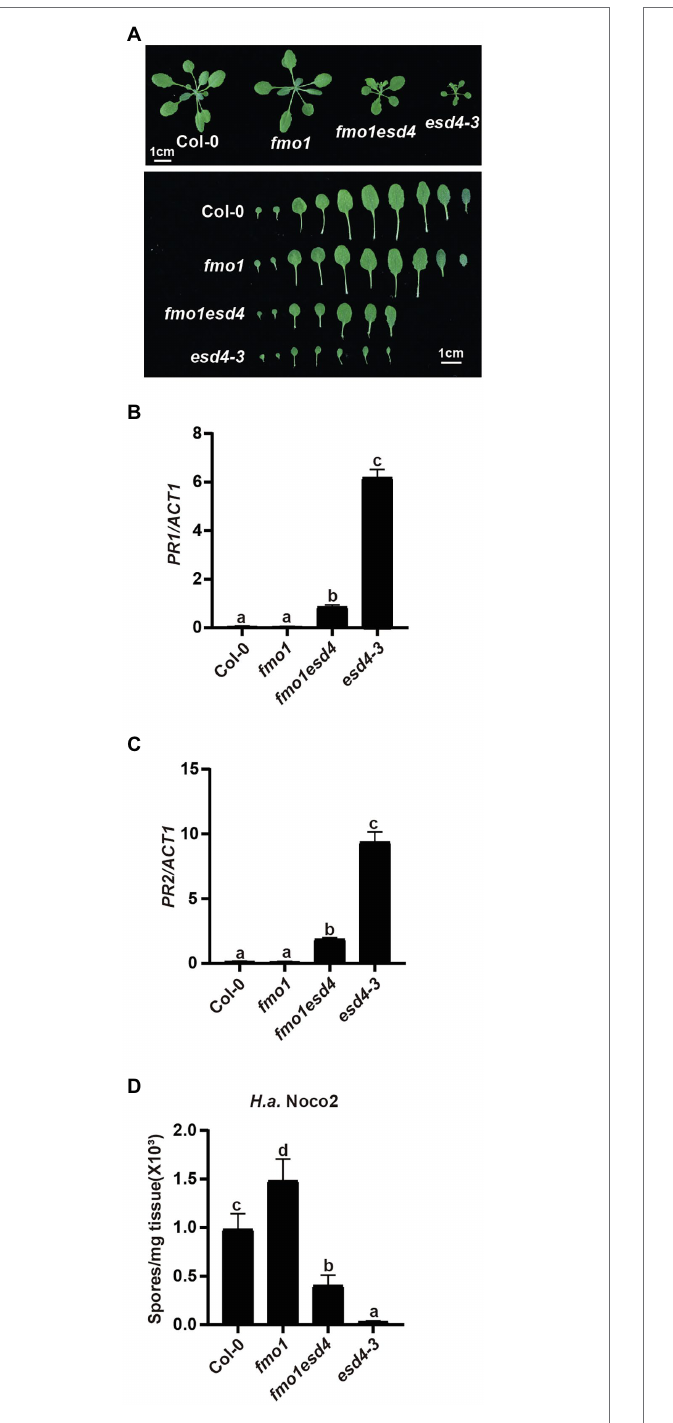
FIGURE 3 | The constitutively activated immunity in esd4 is partially suppressed by fmo1 . (A) Morphologies of 3-week-old soil-grown plants of the indicated genotypes under long-day conditions. (B,C) Expression of PR1 (B) and PR2 (C) in indicated genotypes. ACTIN1 serves as internal control. (D) Growth of H.a. Noco2 on the indicated genotypes. The values indicate averages of replicates ± SD ( n = 3). Different letters indicate statistical differences among different samples ( p < 0.05, one-way ANOVA, n = 3). Experiments were repeated twice with similar results.